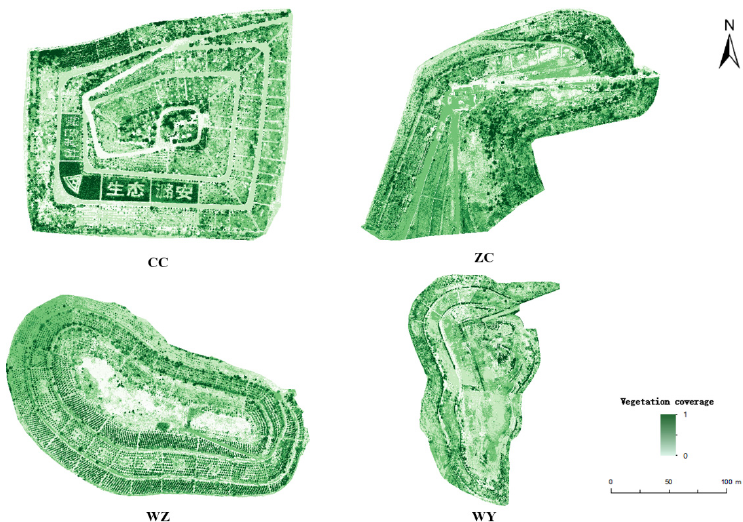
Figure 6. Vegetation coverage map of coal gangue